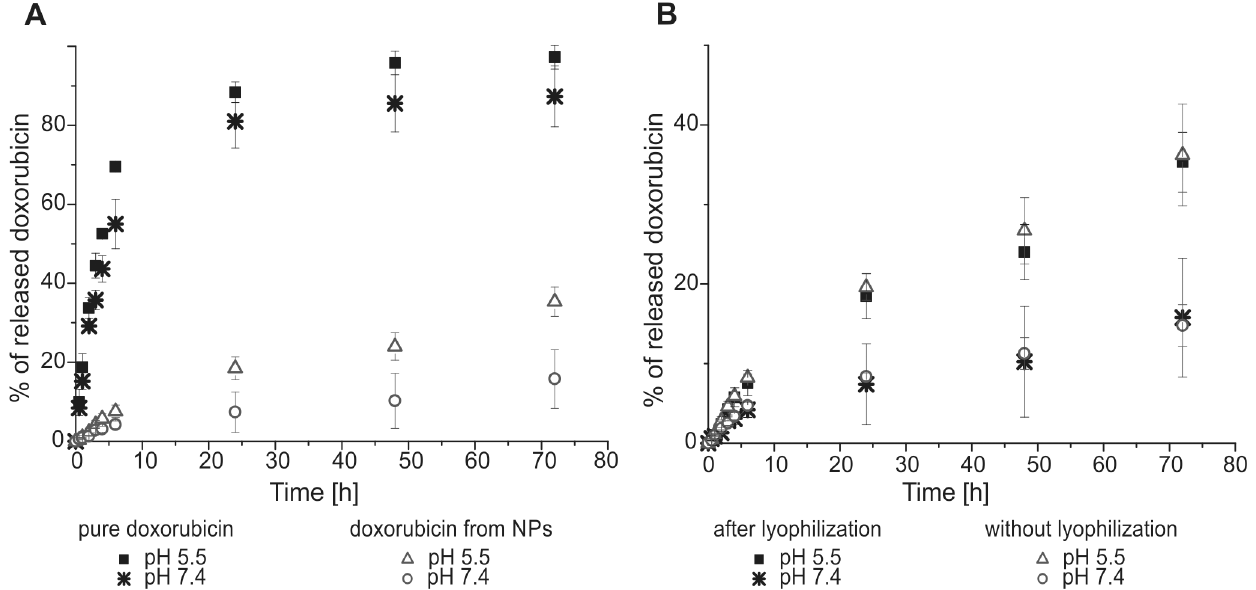
Fig 5. Doxorubicin release rate in PBS. (A) Comparison of doxorubicin release from the dialysis bag in the control group (raw doxorubicin) and Dox-NPs (rehydrateded) in the PBS solution at two pHs (5.5 and 7.4) at 37°C. (B) Effect of NP lyophilization on the rate of doxorubicin release in PBS solution at pH 5.5 and 7.4 at 37°C. Mean n = 3 ±